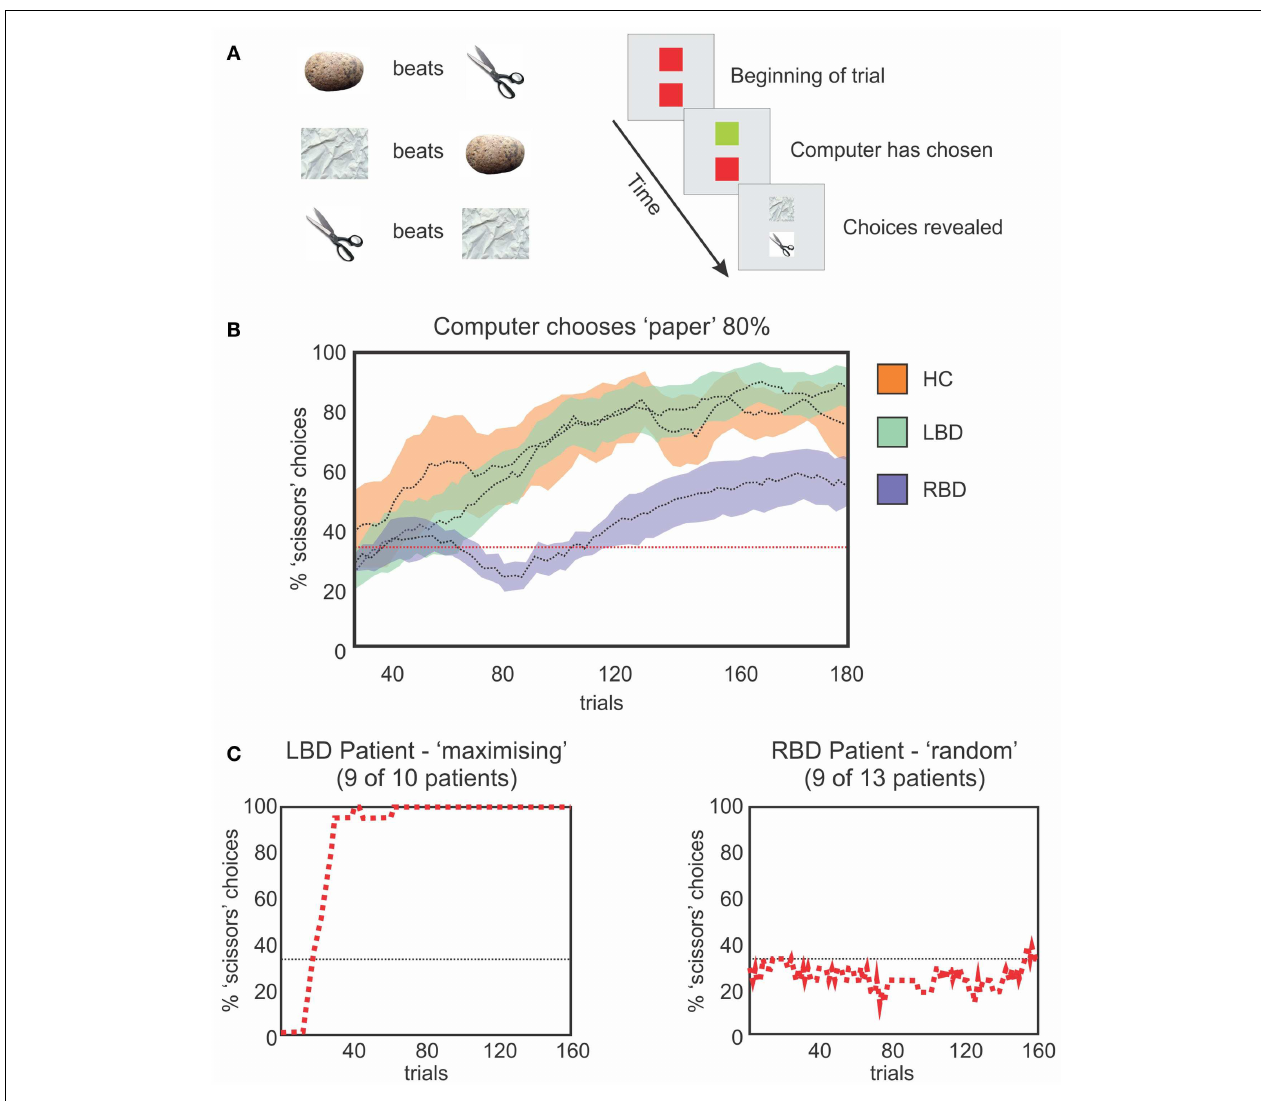
the strong bias of the computer (i.e., 80% paper). HCs (orange) and LBD patients (green) exploit the bias. RBD patients fail to exploit the bias as efficiently. (C) Representative performances from a LBD (left) and RBD (right) patient.The LBD patient maximizes choosing the optimal play 100% of the time.The RBD patient continues to play randomly and